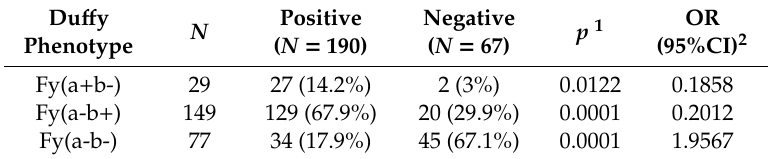
Table 1. Proportion of the three Du ff y phenotypes in P. vivax positive and negative healthy patients Du ff y